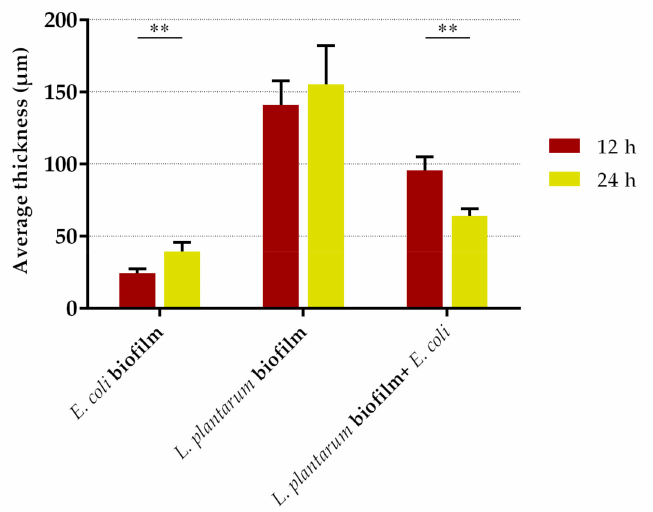
Figure 6. Thickness of single- ( E. coli and L. plantarum ) and dual-species ( L. plantarum + E. coli ) biofilms after 12 and 24 h of contact between the pre-formed probiotic biofilm and the pathogen. This quantitative biofilm parameter was determined from confocal z -stacks using the plug-in COMSTAT2 associated with the ImageJ software. The data present the mean and standard deviation (SD) of at least five stacks of each sample. Statistically significant differences between exposure times were considered for p -values < 0.05 (** indicates p <